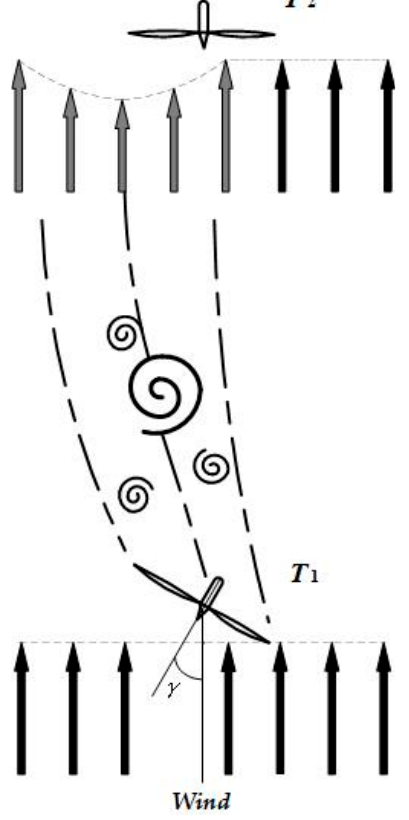
Figure 4. Control diagram of yaw-based wake redirection.